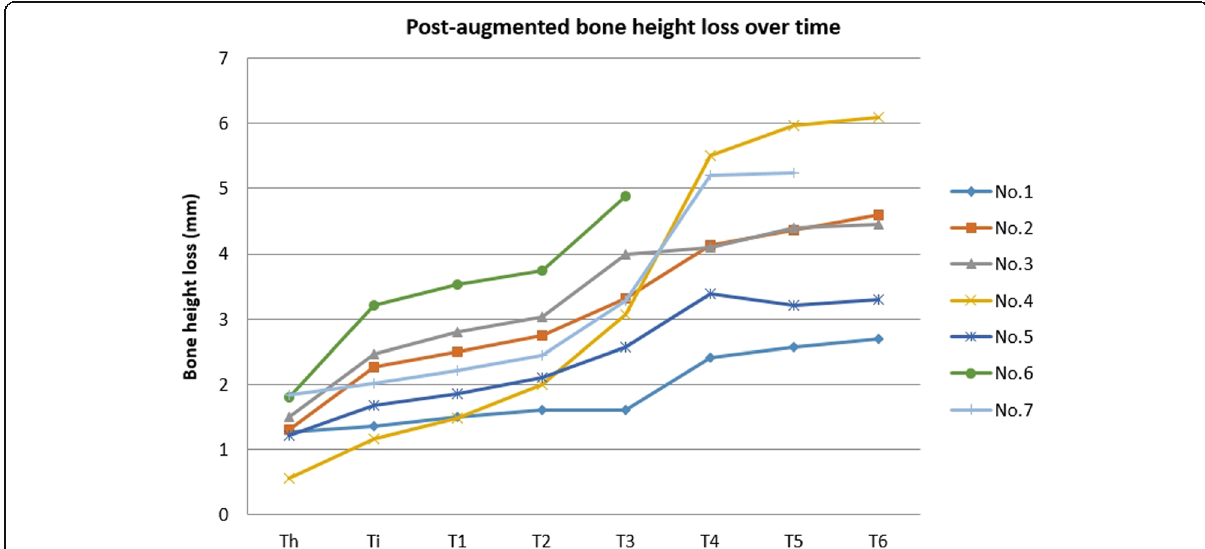
Fig. 5 Mean bone height loss over time in individual patients. Th: 3 months post-augmentation, Ti: at implant installation, T1: 3 months after installation, T2: at prosthetic loading, T3: 1year after installation, T4: 2years after installation, T5: 3years after installation, T6: 5years after installation. In each patient, bone height changes showed high rates of bone resorption during the early period and in the first year after implant installation. Upon further follow-up, the bone height loss 3years and 5years post-installation did not differ significantly ( p <0.05)